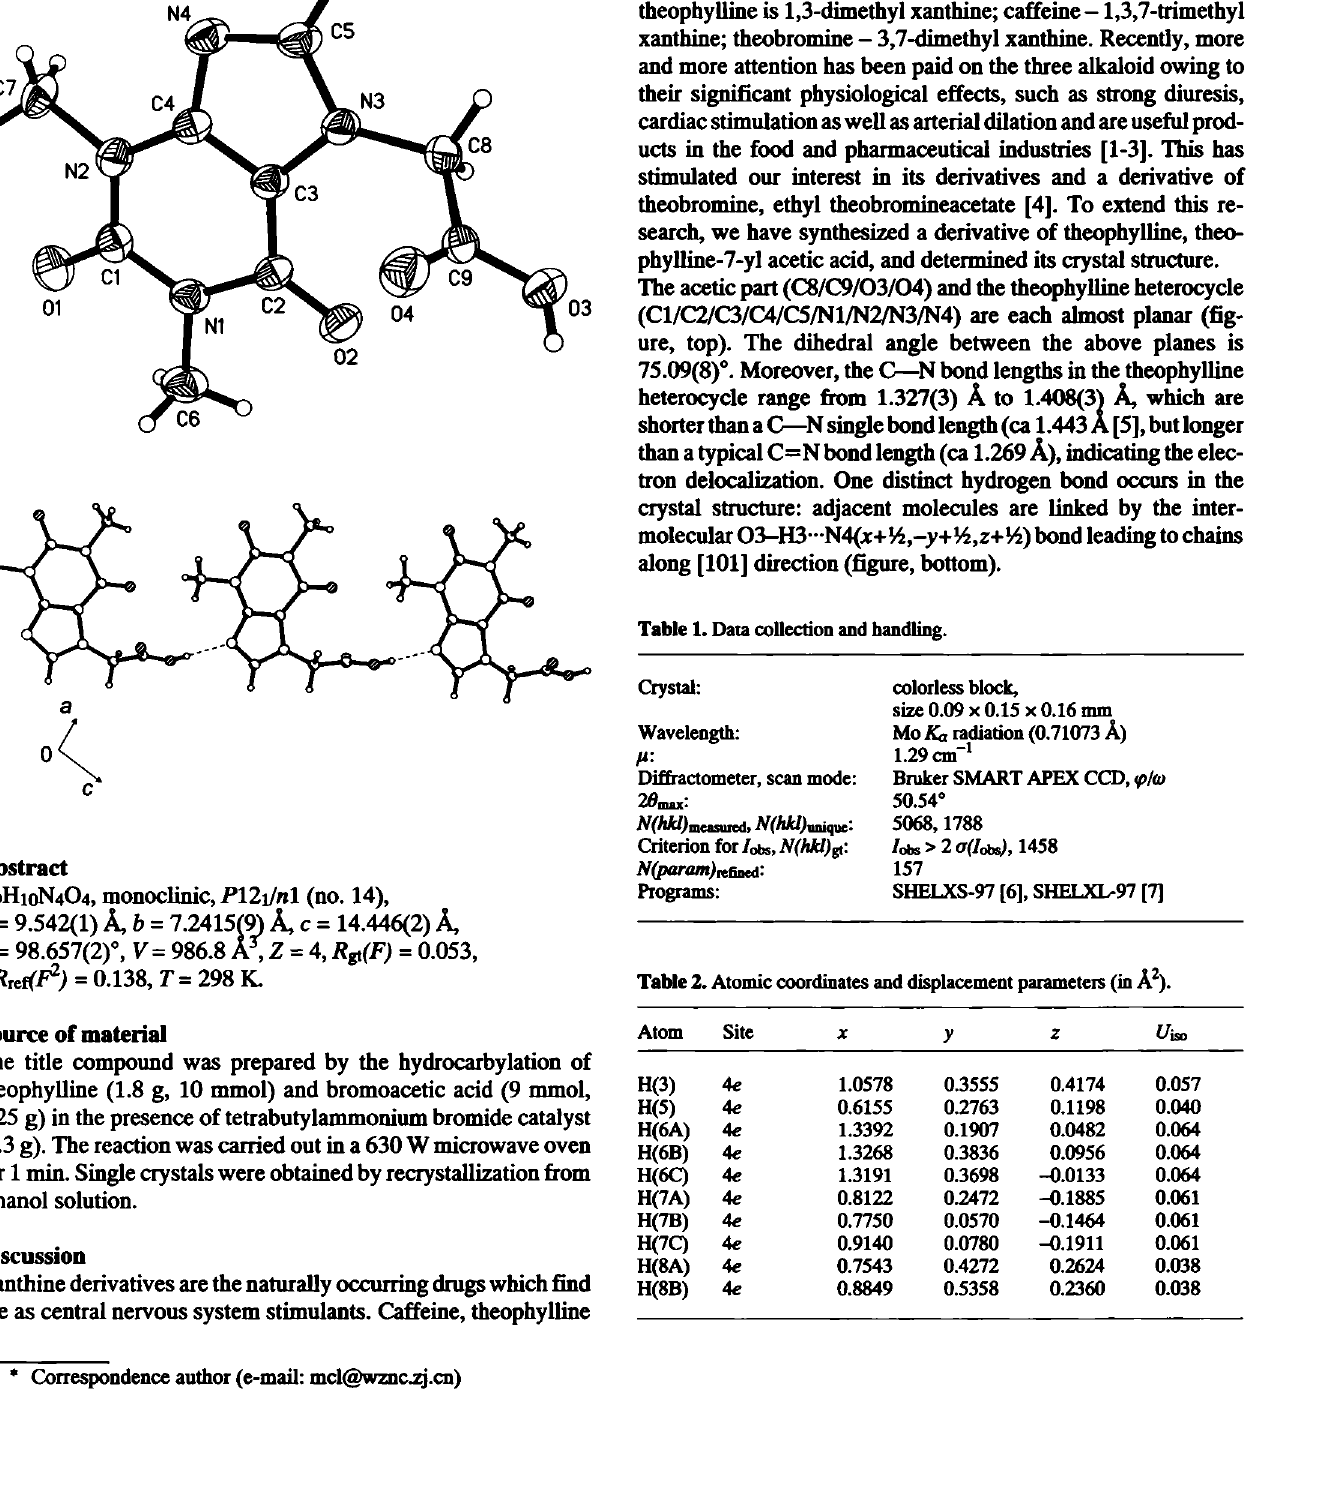
Table 2. Atomic coordinates and displacement parameters (in Ä 2